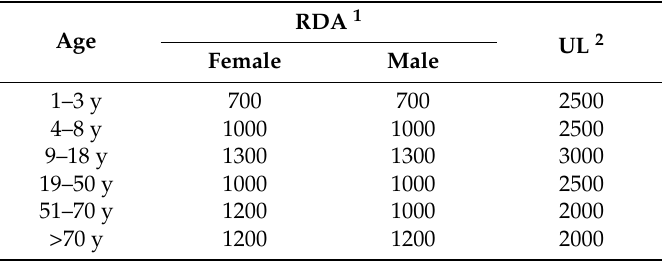
Table 1. Calcium recommendations for Americans (mg/d) [12].